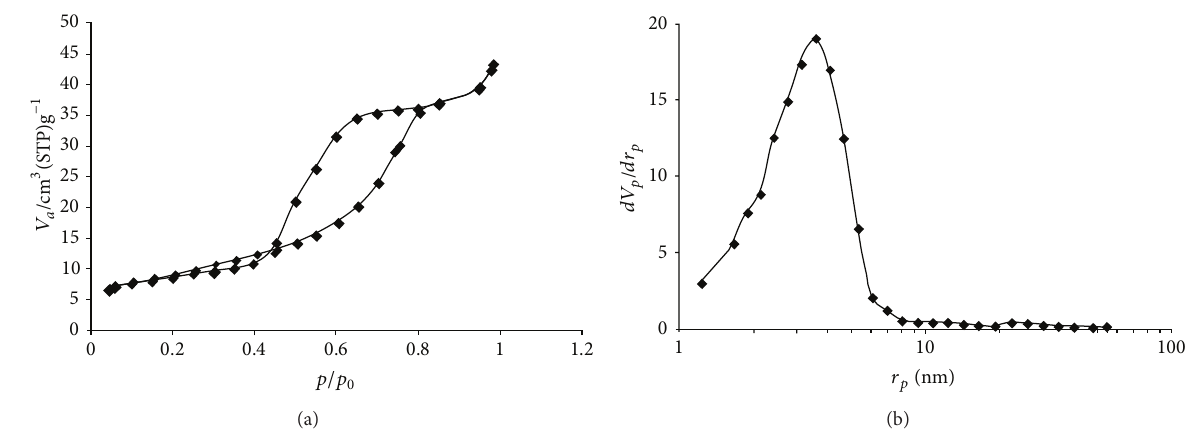
Figure 15: (a) The results obtained by BET method: N 2 adsorption and desorption isotherms and (b) BJH pore diameter distribution of the unsupported anatase membrane.